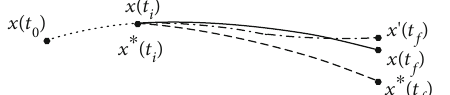
Figure 6: Iterative optimization process.